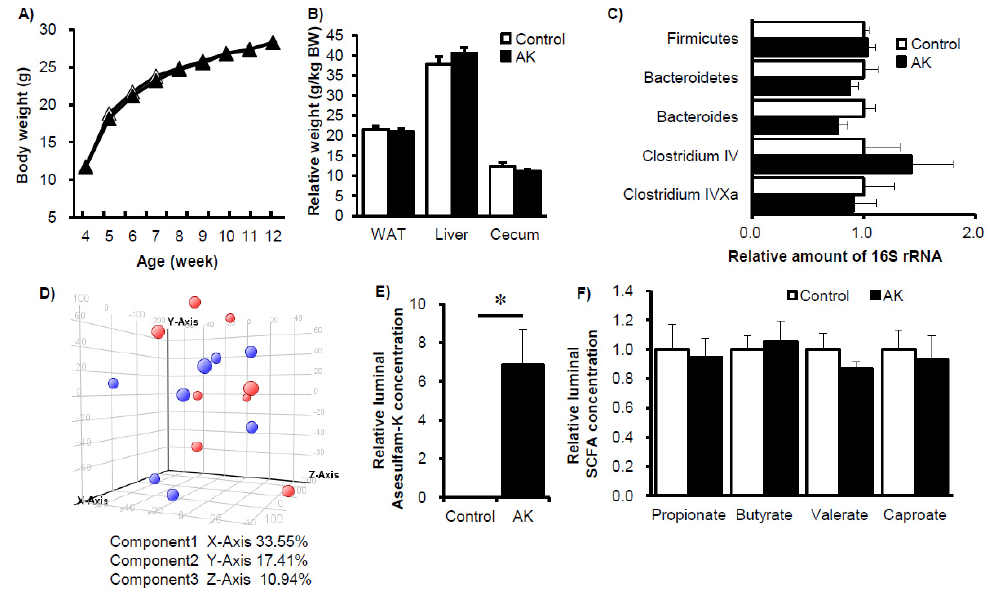
Figure 4. Gradual changes in body composition, gut microbiota and luminal metabolites in mice fed acesulfame-K. Changes in body weight ( A ), organ weight ( B ), and abundance of specific bacterial phylum and genus ( C ) after 8 weeks of acesulfame-K feeding (AK). Principle component analysis of 82 luminal metabolites in acesulfame-K fed mice ( D ). Changes in relative concentration of acesulfame-K ( E ) and short chain fatty acids ( F ) in mice fed acesulfame-K for 8 weeks. Data represent mean ± S.E. ( n = 8). * p < 0.05 as compared to the control